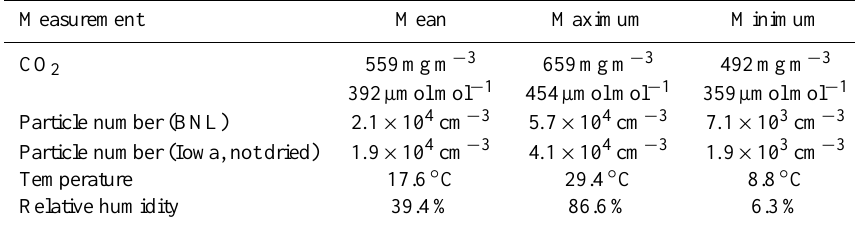
Table 2. Mean values and distributions of ground-based measurements at T0 from 10 March to 25 March 2006.